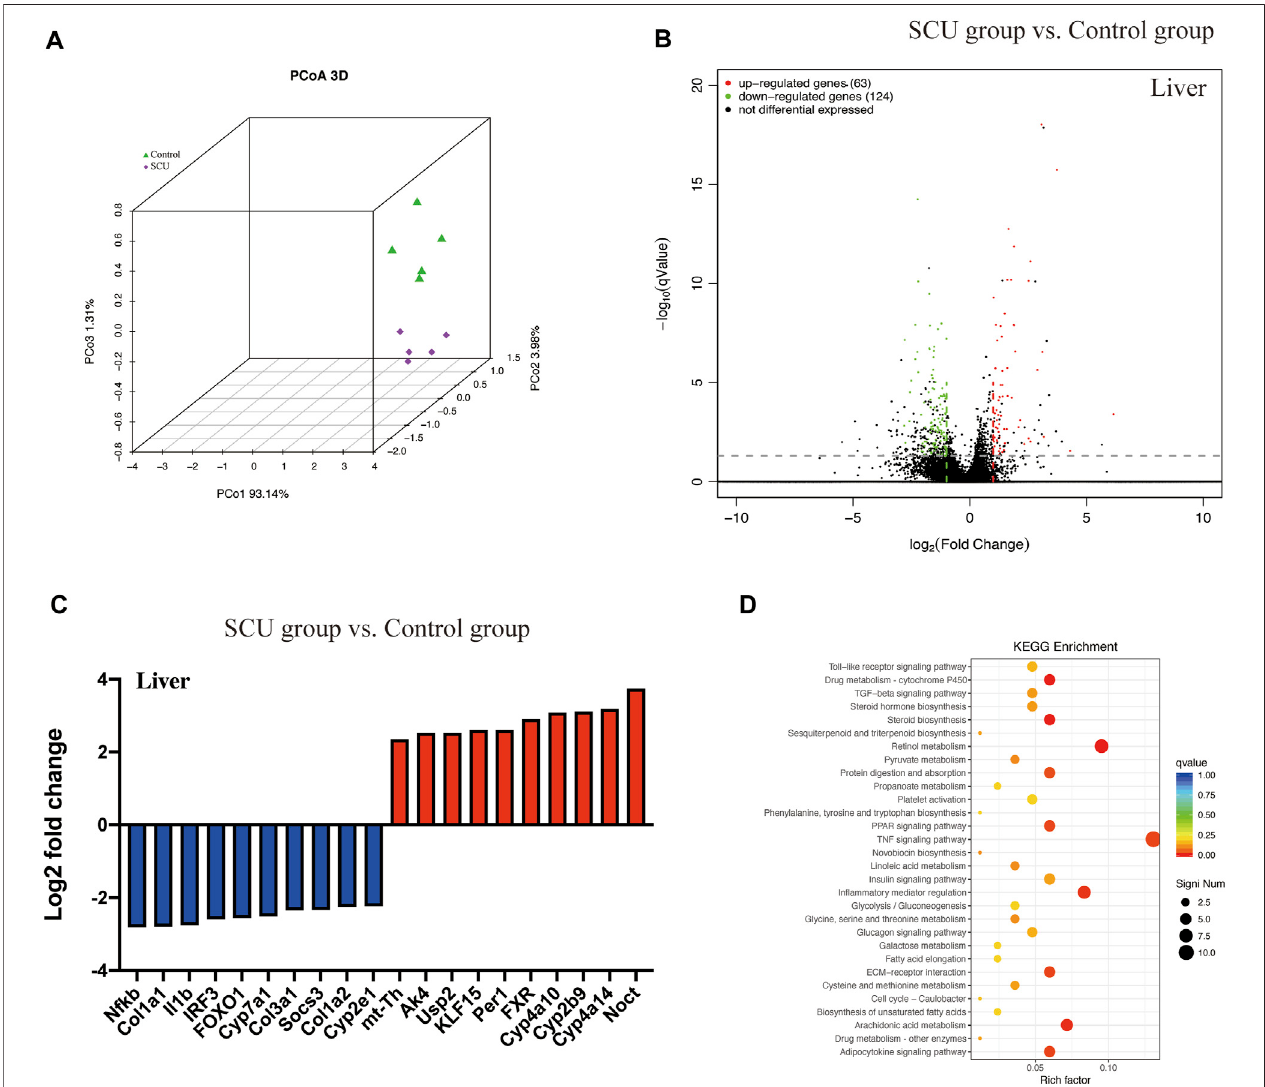
FIGURE1 | SCU displayed hepatoprotective potential. (A) Principal coordinate analysis (PCoA). (B) Volcano plot of transcripts. (C) Top 20 transcripts in liver tissues. (D) KEGG pathway. ( n (cid:1) 5).